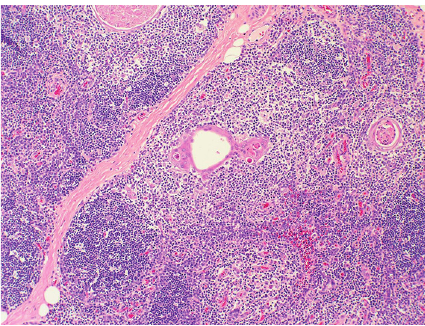
Figure 2: Hematoxylin and eosin, 20x. Thymic tissue, highlighting Hassall’s corpuscles (central).